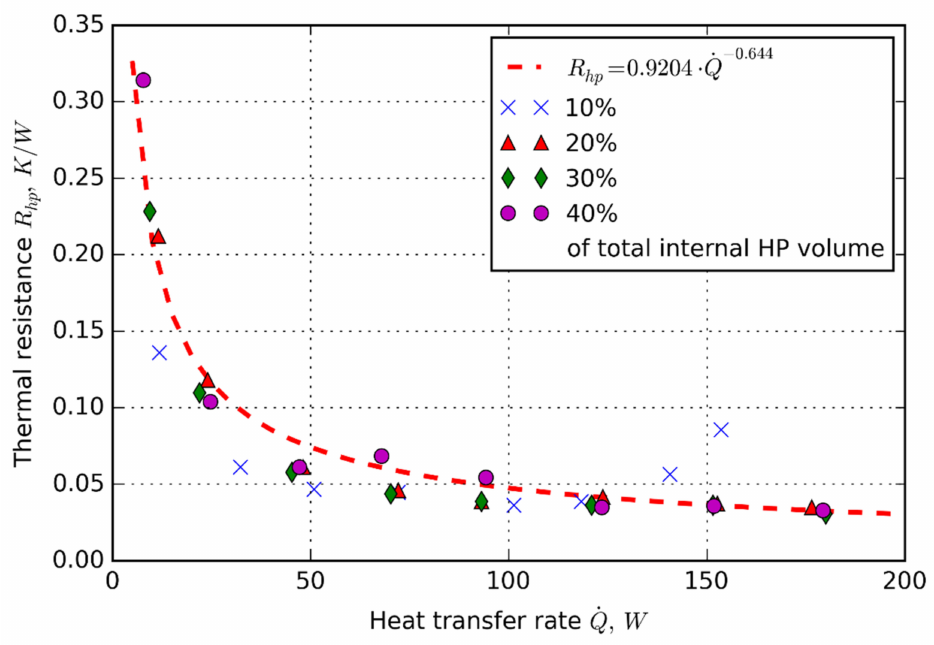
Figure 3. Thermal resistance of 32 mm outer diameter heat pipe vs. heat transfer rate for different filling ratios